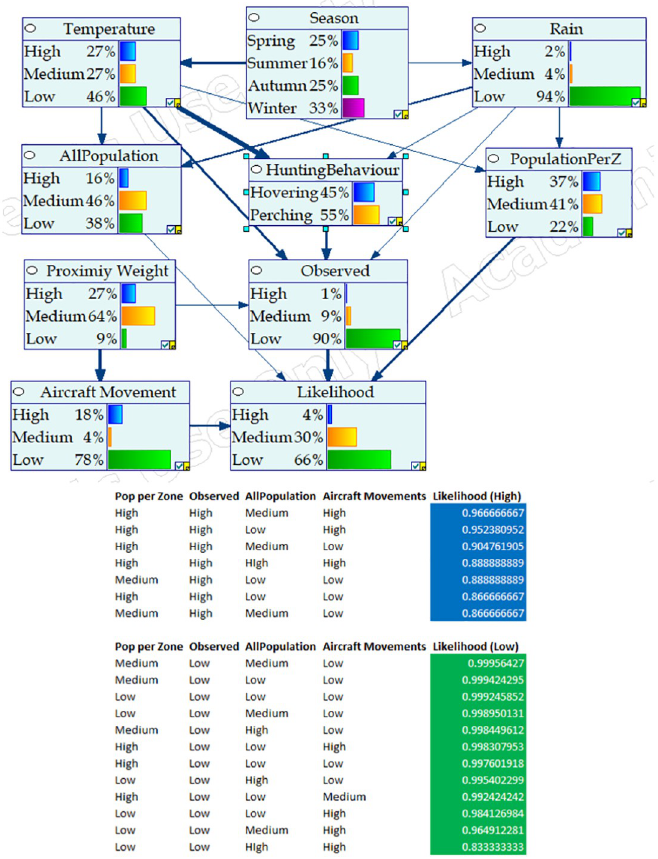
Fig 5. BNM configuration for Nankeen Kestrel including conditional probabilities and indicative variables for high and low collision likelihood. Node influence strength is given by the width of connecting arcs.